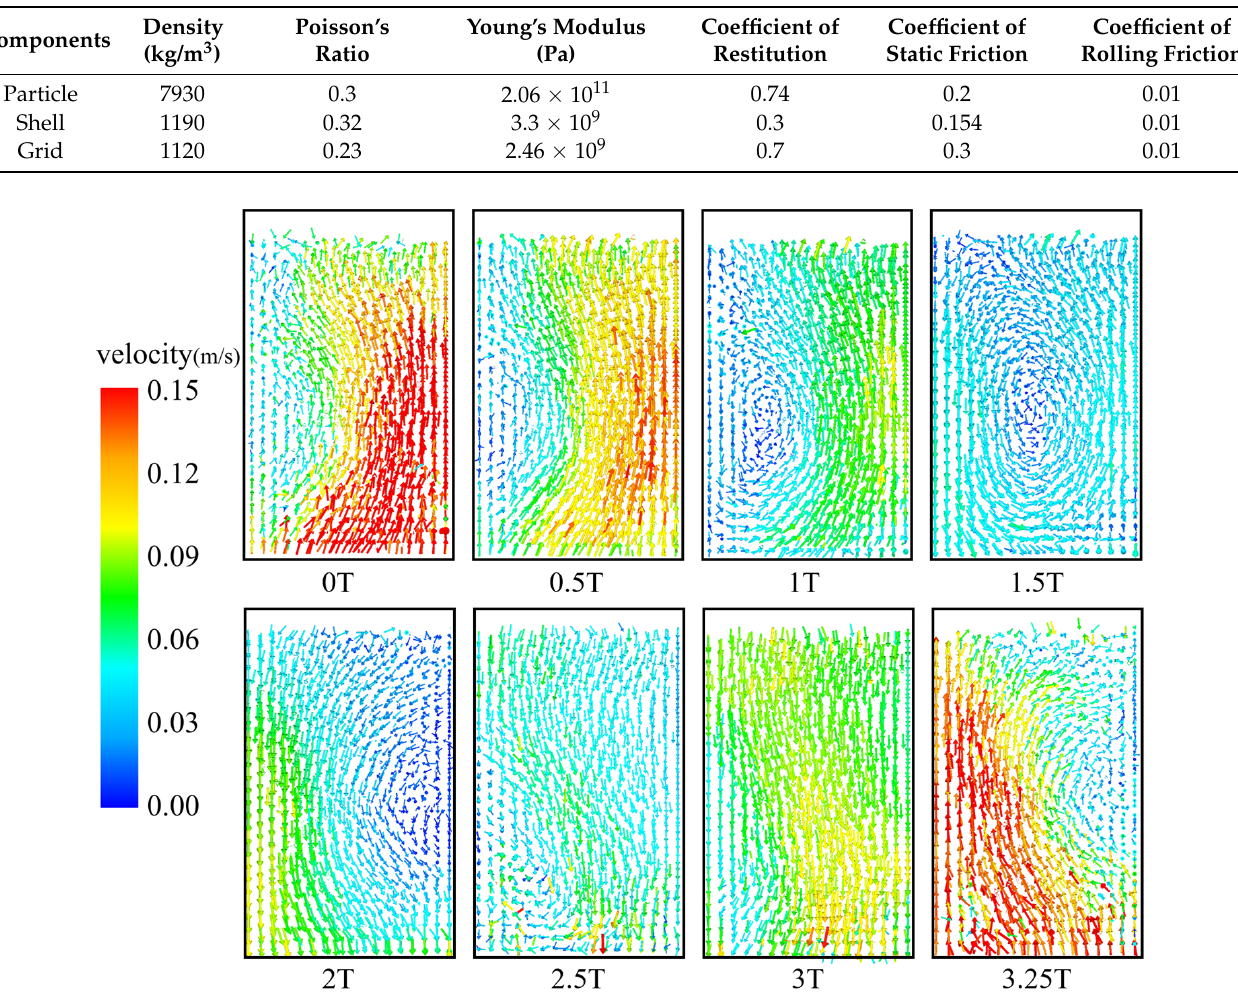
Table 5. Physical properties and parameters used in DEM simulation.